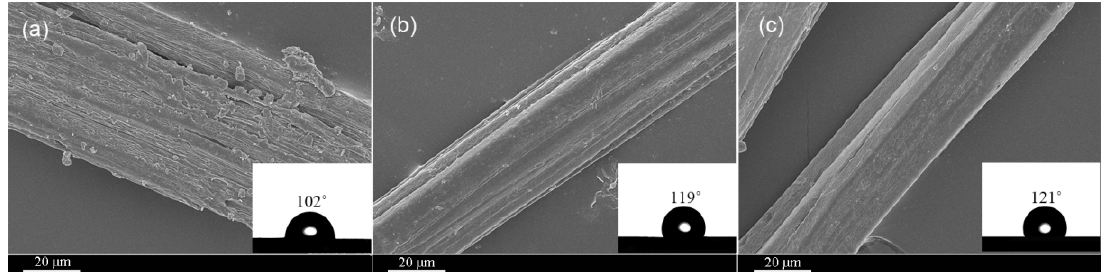
Figure 9. Surface morphology and water contact angle of the cotton stalk fibers ( a ) untreated, ( b ) treated in alkali/glycerin solution and ( c ) treated in alkaline aqueous solution.